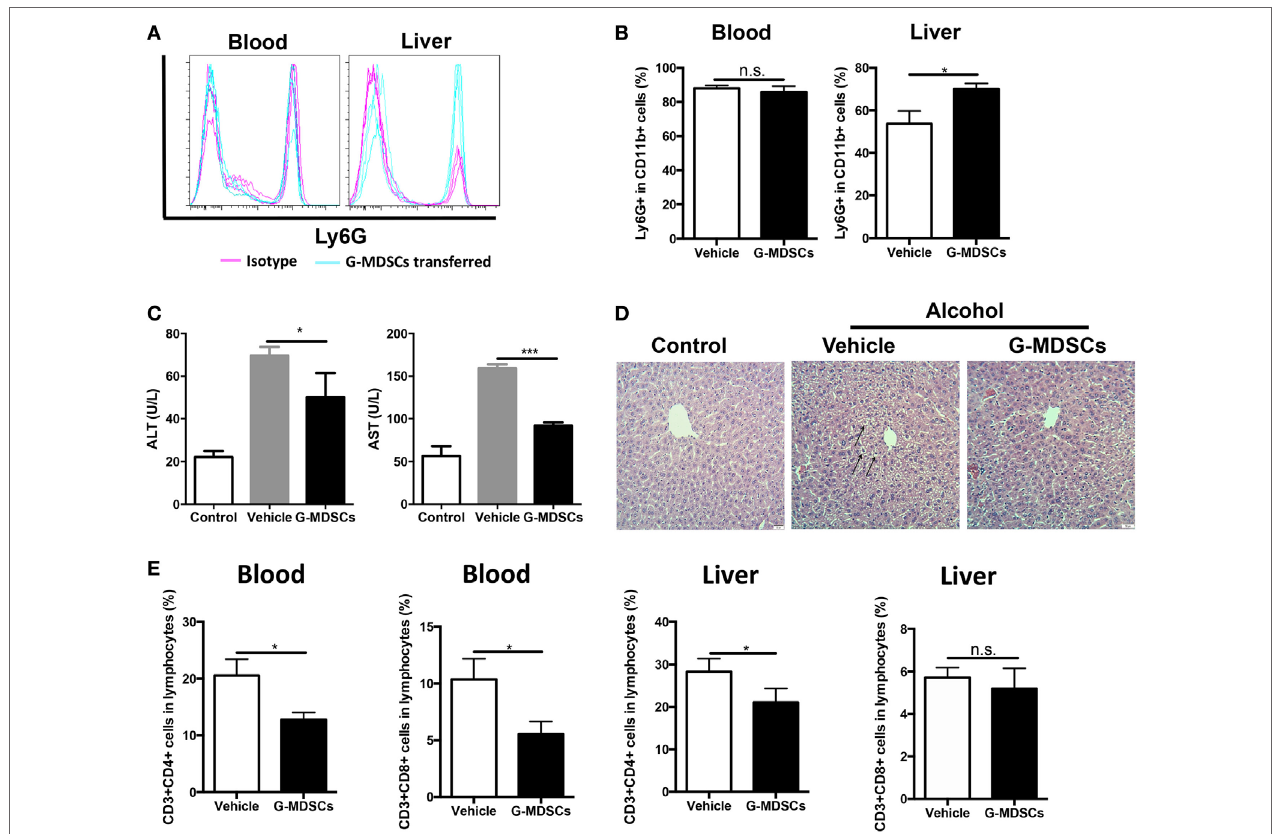
FigUre 3 | Adoptive transfer of granulocytic-MDSCs (G-MDSCs) populations alleviated liver injury induced by ethanol. About 1 × 10 7 CD11b + Ly6G high Ly6C int cells with over 90% purity in 200 µL PBS were injected into naïve mice before receiving ethanol ( n = 5). The populations of myeloid-derived suppressor cells (MDSCs) and T cells in blood and liver were determined by flow cytometer and then liver function was evaluated via serological and histological examination. (a) Representative histogram images and (B) quantification of flow cytometric analyses of G-MDSCs populations in blood and liver of mice receiving PBS or transferred G-MDSCs. The population of G-MDSCs was significantly increased in the liver after G-MDSCs adoptive transfer, while their percentage was comparable in blood. (c) Alanine aminotransferase (ALT) and aspartate aminotransferase (AST) levels in serum of normal mice, ethanol model mice with vehicle injection, and ethanol mice with G-MDSCs transferred. (D) The representative H&E staining images of liver tissue from normal mice, ethanol model mice with vehicle injection, and ethanol mice with G-MDSCs transferred. The hepatocellular apoptosis and single cell necrosis were indicated by arrows. (e) Population of T helper cells and cytotoxic T cells in the blood and liver of model mice and G-MDSCs-treated mice. Data were analyzed as mean value ± SD and Student’s T -test was used to assess the result significance. * p < 0.05, *** p < 0.001, compared with the control group; n.s., not